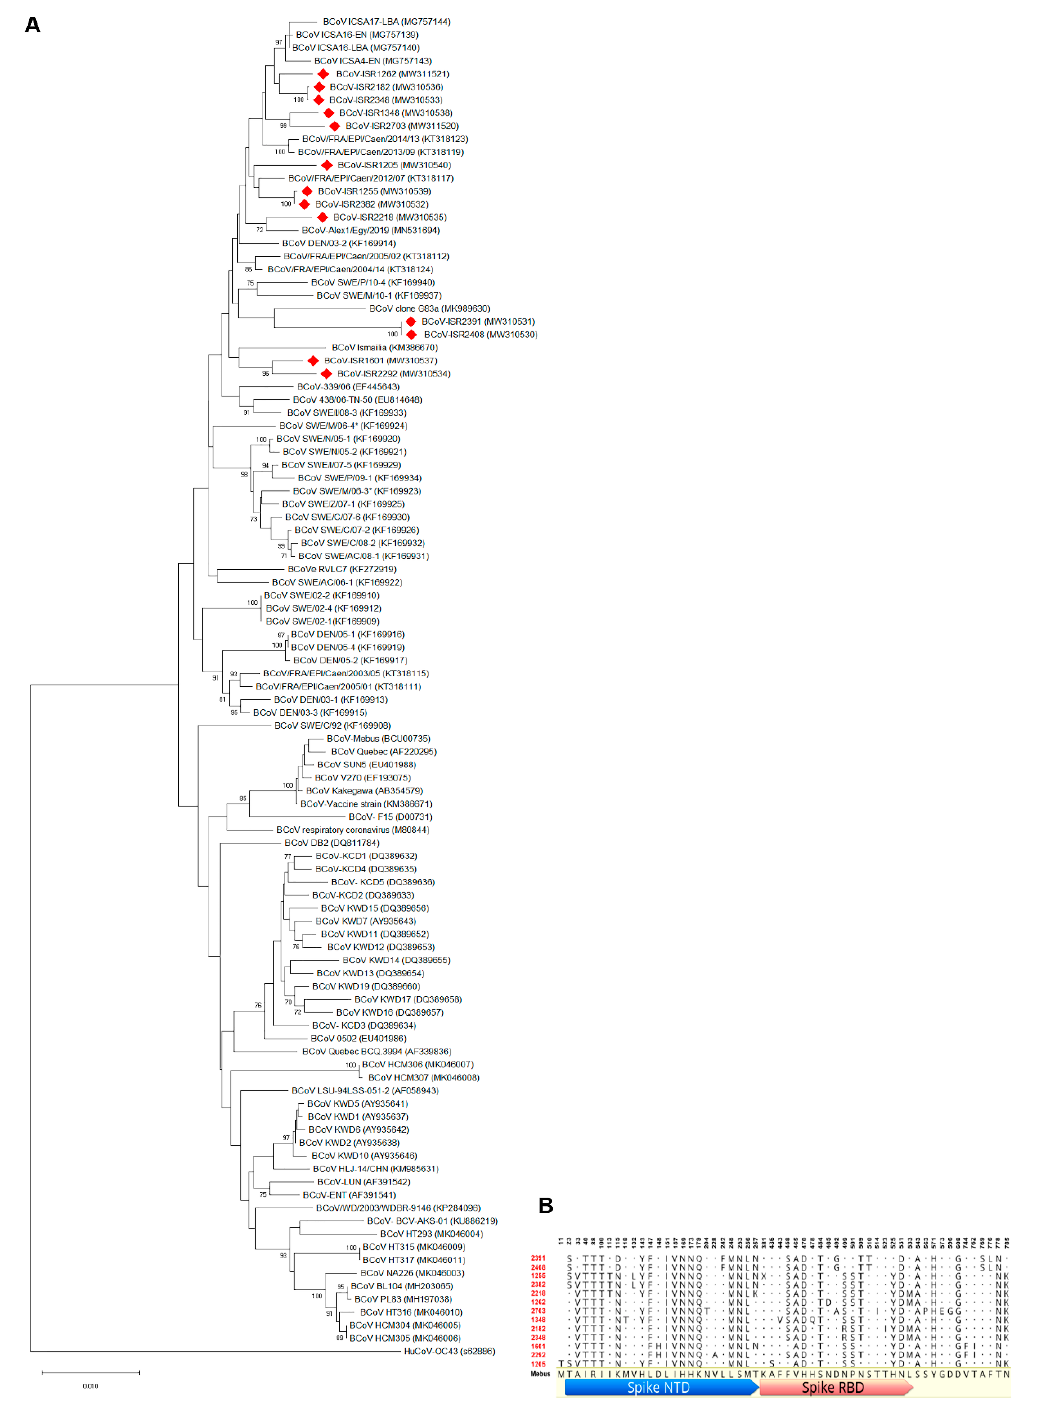
Figure 2. Phylogenetic tree of the partial Spike gene of Bovine coronavirus (BCoV) from local isolates. ( A ) Phylogenetic tree of S1 region of BCoV spike glycoprotein. BCoV genomic RNA was isolated from feces of WD diseased cattle and used for molecular characterization of the S1 region. Local isolates (labeled in red) were aligned with selected reference strains. Phylogenetic tree generated based on S1 nucleotide sequences (nucleotides 1–2731) was generated via the neighbor-joining method with bootstrap analysis (1000 replicates, > 70%). The scale bar shows the number of substitutions per site. We used HCoV OC43 as an outgroup strain. Spike partial sequences were retrieved from GenBank and embedded in the figure for each strain. ( B ) Deduced amino acid sequences of S1 from local isolates aligned to reference strain Mebus. Local isolate sequences were aligned using Geneious protein alignment tool to show only disagreements residues compared to the reference sequence of Mebus strain.